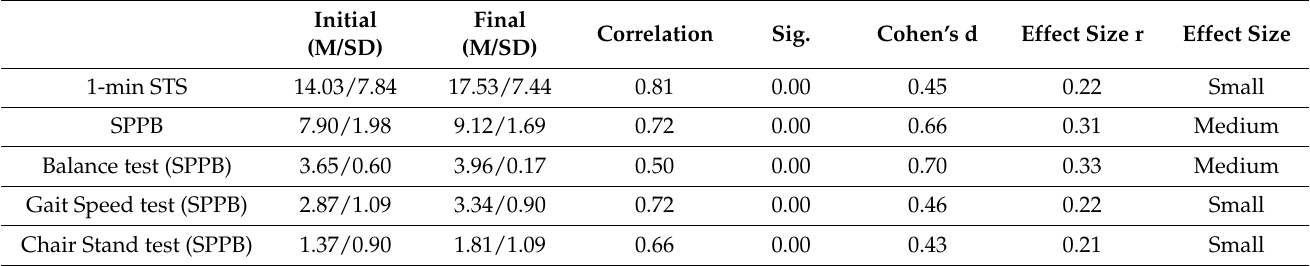
Table 3. Results of the 1-min STS: the 1-min STS test and SPPB: the short performance physical battery